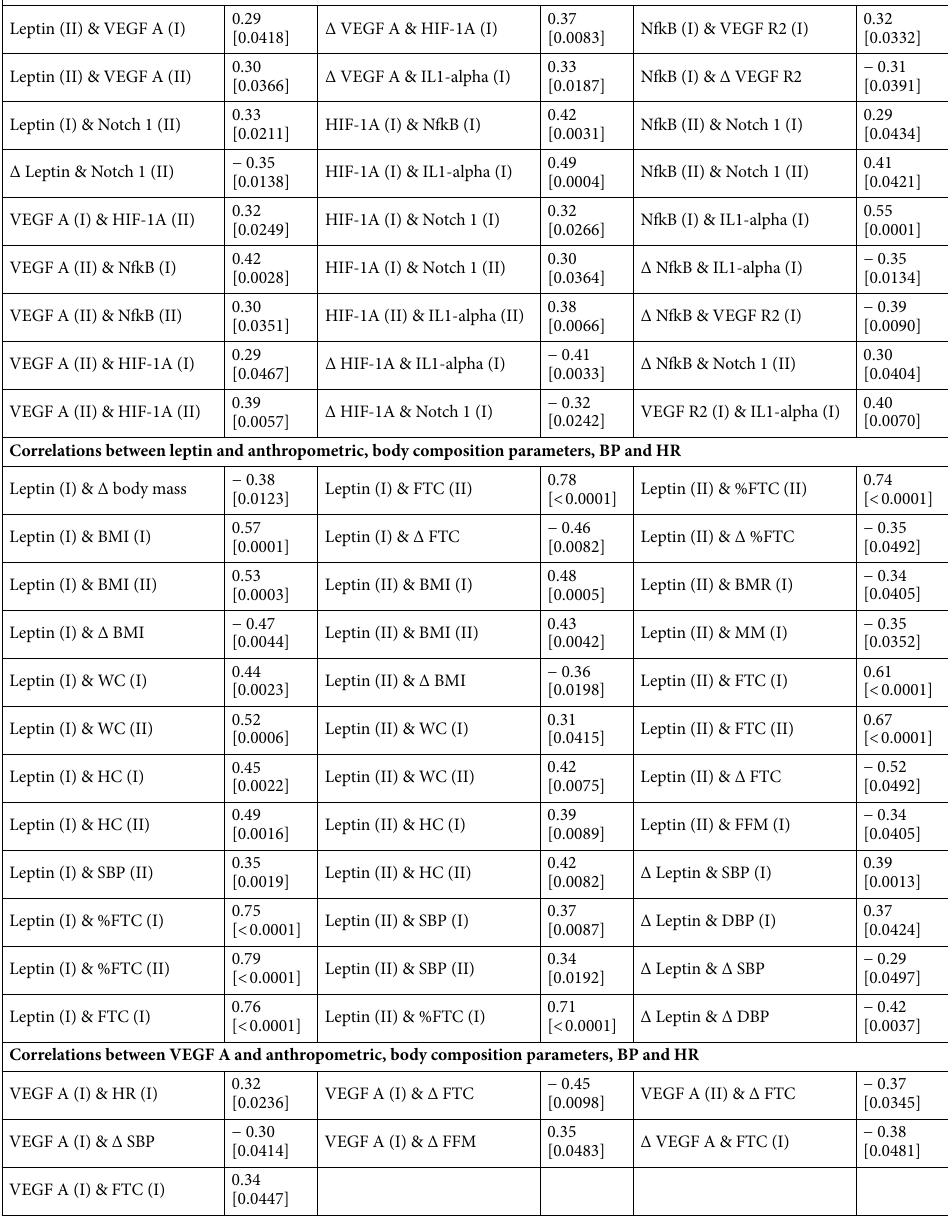
Table 7. Significant correlations between registered parameters in group S. Data presented as the Spearman correlation coefficient R value; p value is presented below R value in square bracket []. %FTC: percentage fat tissue content; BMI: body mass index; BMR: basal metabolic rate; DBP: resting diastolic blood pressure; FFM: fat-free mass; FTC: mass fat tissue content; HC: hip circumference; HIF-1A: hypoxia-inducible factor 1 alpha; HR: resting heart rate; IL1-alpha: interleukin 1 alpha; MM: muscle mass; NfkB: nuclear factor kappa-light- chain-enhancer of activated B cells; Notch 1: Notch protein 1; SBP: resting systolic blood pressure; VEGF A: vascular endothelial growth factor A; VEGF R2: vascular endothelial growth factor receptor 2; WC: waist circumference. (I): value before intervention; (II): value after the intervention; Δ: change/delta = value in group S (II) – value in group S